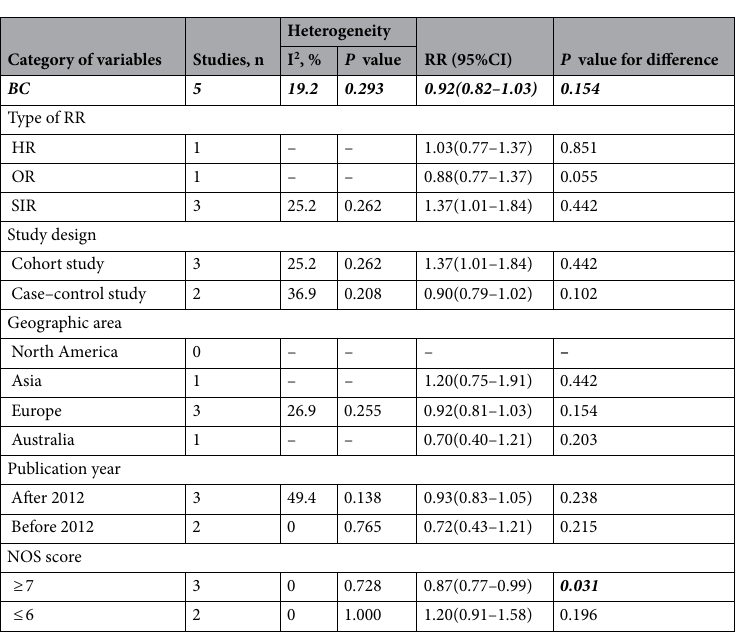
Table 4. Subgroup analysis of association between BC risk. HCV = hepatitis C; RCC = renal cell carcinoma; BC = bladder cancer; PCa = prostate cancer; RR = relative risk; HR = hazard ratio; OR = odds ratio; SIR = standardized incidence ratio; NOS = Newcastle–Ottawa